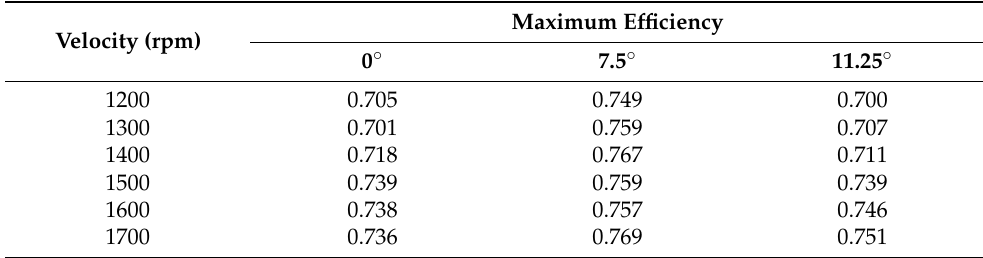
Table 4. Maximum efficiency at different velocities and angles.